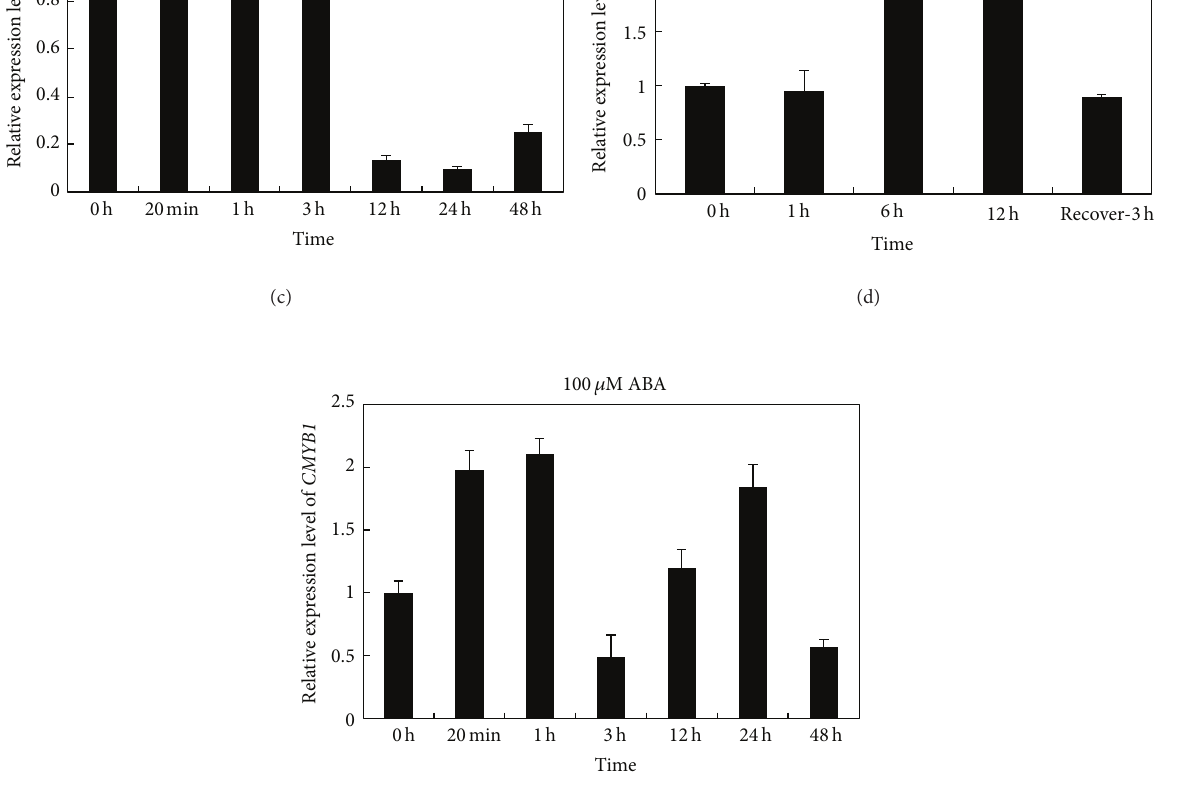
Figure 3: The abiotic-stress-induced expression pattern of CMYB1 . Jiucaiqing three-leaf seedlings were treated with 4 ∘ C (a), 20% PEG6000 (b), 100mM NaCl (c), dehydration (d), and 0.1mM ABA (e),